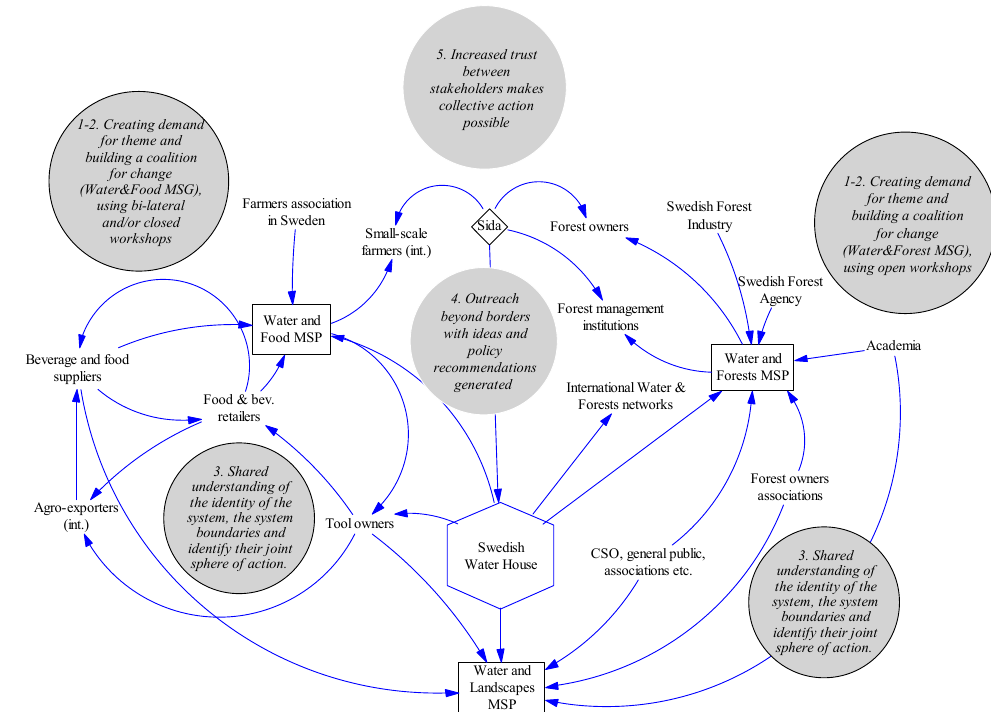
Figure 2. The approach for building multi-stakeholder platforms for dialogues on water, food, forests and landscapes with key boundary partners and stakeholders involved in the process and their interlinkages.